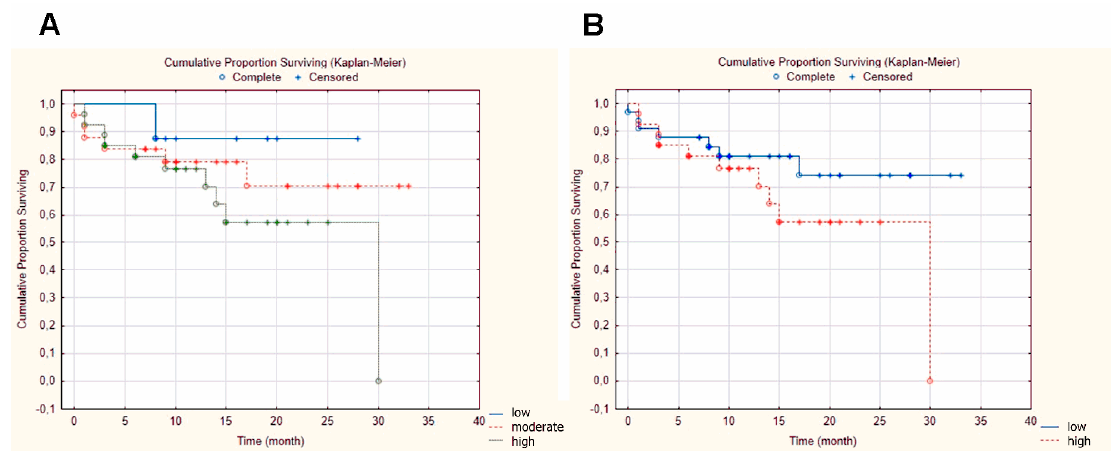
Figure 2. Kaplan–Meier survival curves. ( A ) Correlation between GnRH-R expression and disease-specific survival showing the 3 scores groups—low, moderate, and high expression ( p = 0.556); ( B ) Correlation between GnRH-R expression and disease-specific survival showing the dichotomized scores groups—low and high expression ( p = 0.423).